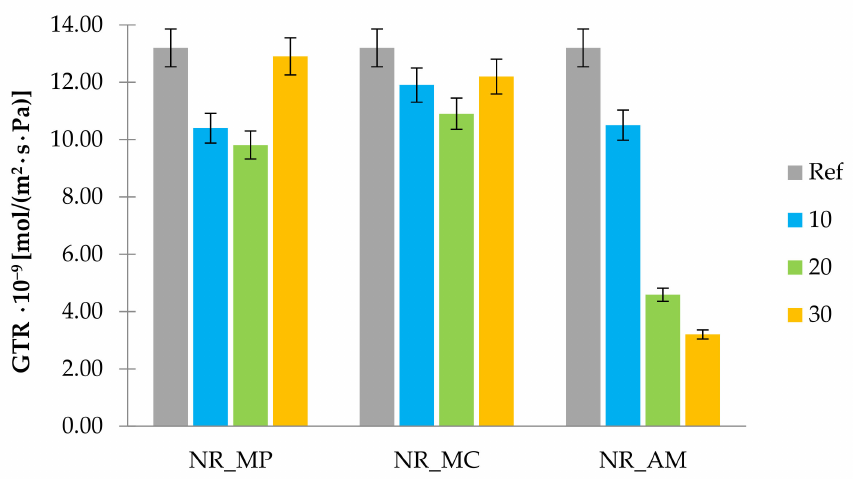
Figure 11. Gas transmission rate of